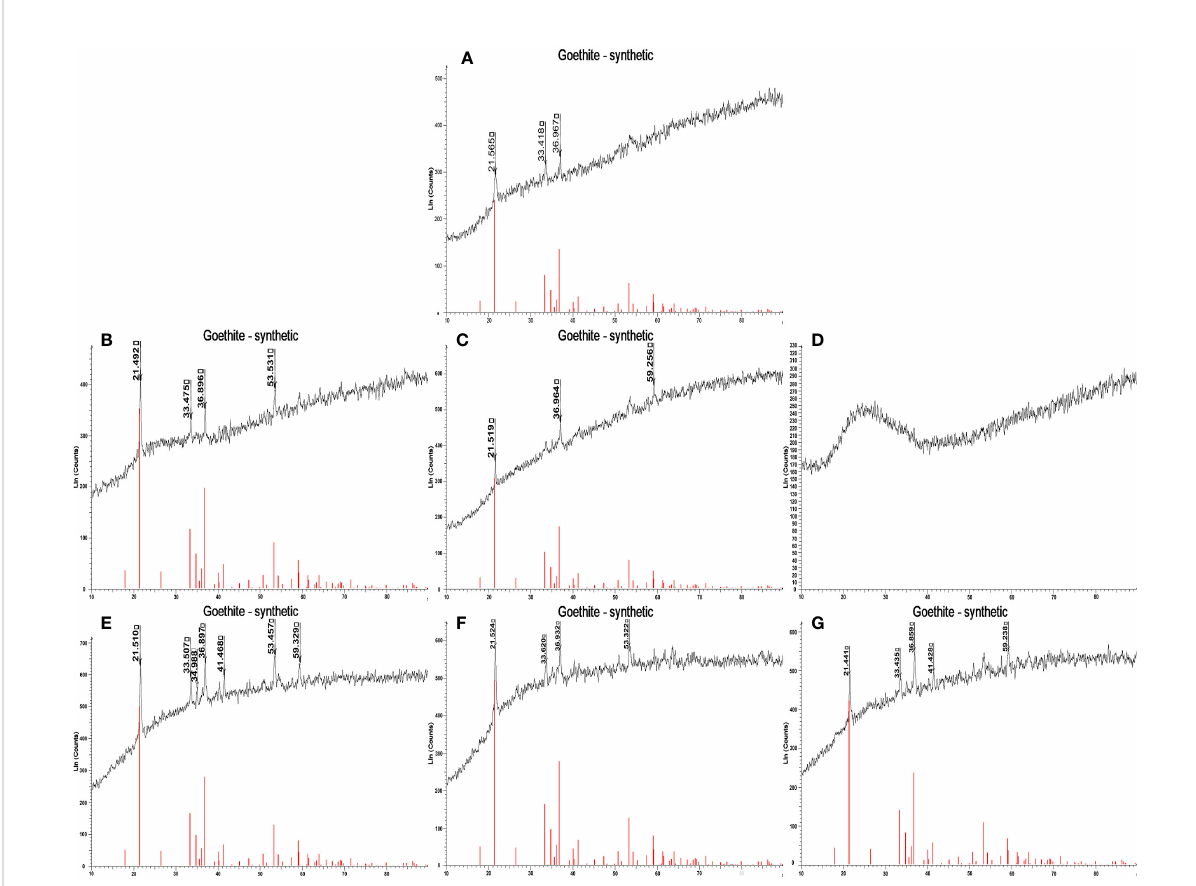
FIGURE 5 X-ray diffraction (XRD) spectra of the crystals with different treatment. (A) blank control, (B) 35 µg/ml CtCBP-1, (C) 70µg/ml CtCBP-1, (D) 140 µg/ml CtCBP-1, (E) 35 µg/ml MBP, (F) 70 µg/ml MBP, (G) 140 µg/ml